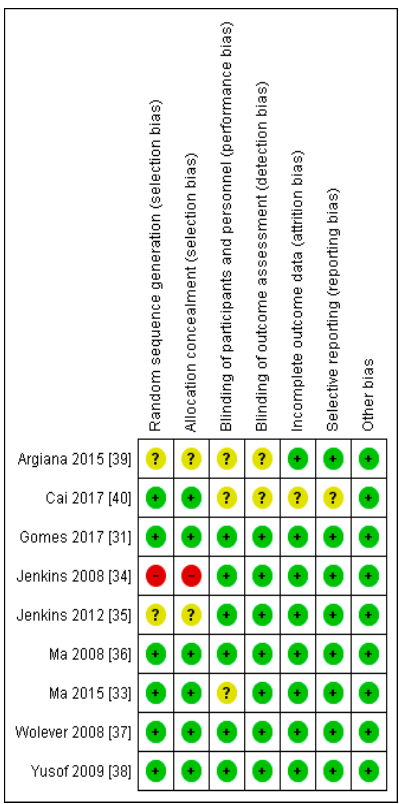
Figure 3. A risk of bias graph for each included study.